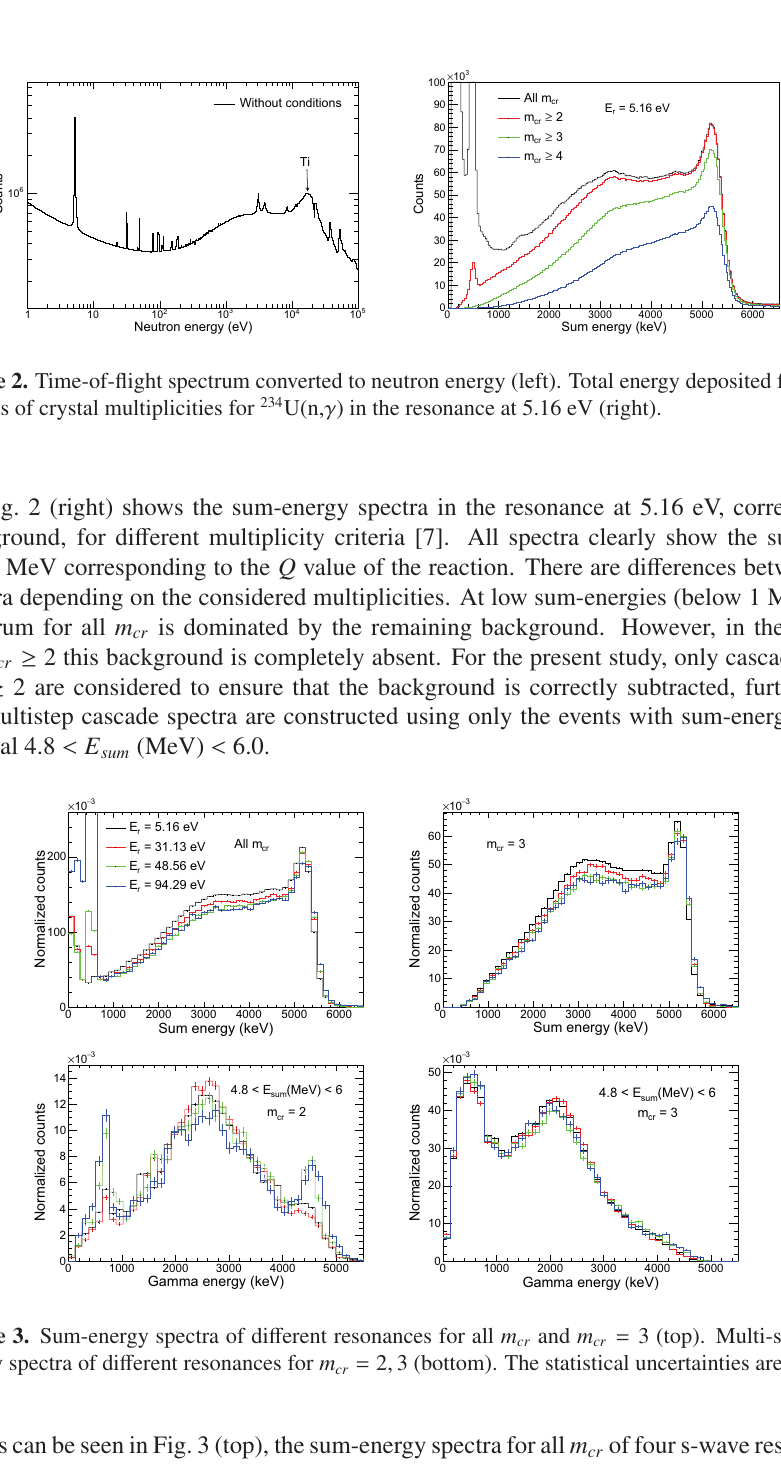
As can be seen in Fig. 3 (top), the sum-energy spectra for all m cr of four s-wave resonances show significant di ff erences at low energy only. These di ff erences are due to the fact that the subtraction of the background is approximative – the remaining background induced by the scattered neutrons is most apparent in the resonance at E r = 94 . 29 eV (blue) due to